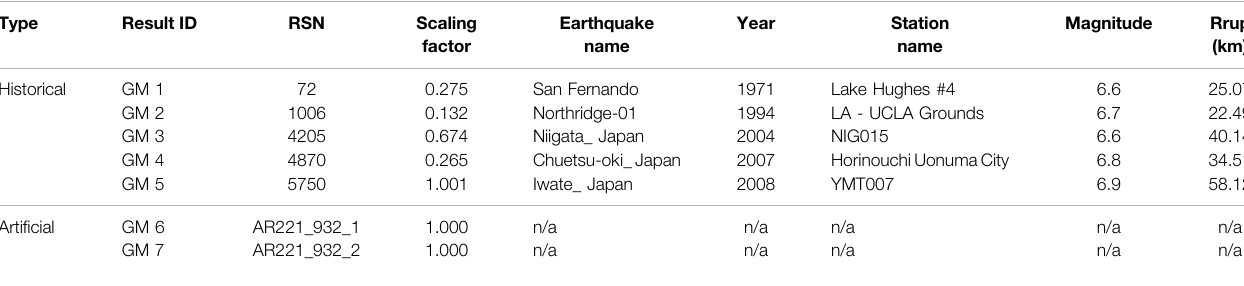
TABLE 5 | Selected ground